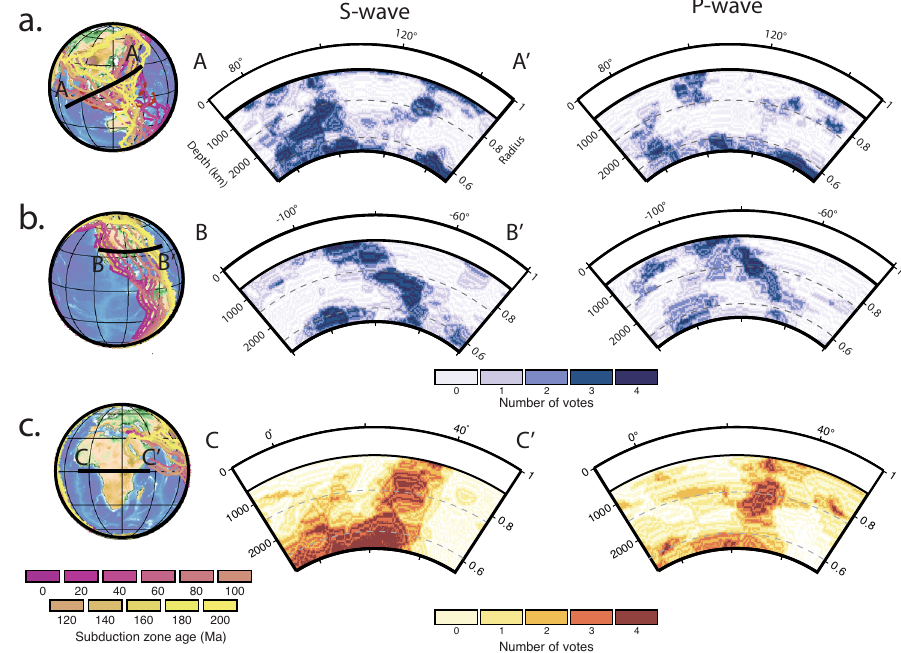
Fig. 6 Vertical cross-sections through the vote maps. All four S-wave models (left) and four P-wave models (right) are used for pro fi les through ( a ) SE Asia and b the Farallon slab regions (vote maps for fast velocities), and ( c ) the African-Afar large low shear wave velocity province (LLSVP) and plume region (vote maps for slow velocities). Location maps are overlain with palaeo-subduction zones between 0 and 200 Ma as extracted from a global plate reconstruction 77 . Panels ( a ) and ( b ) identify vertically coherent fast regions that are common to S-wave models in the mid-mantle indicating the presence of subducted slabs whereas the slab signal is weak amongst P-wave models. This is more clear in the fast rather than ( c ) slow regions because at higher temperatures the HS-LS crossover shifts to greater depths where the seismic signal is dominated by the LLSVPs, and also occurs over a broader depth